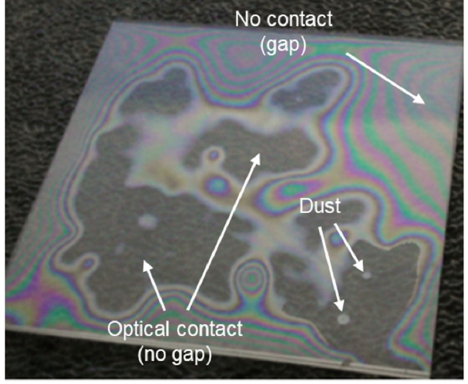
Figure 3. Two glass plates in local contact.